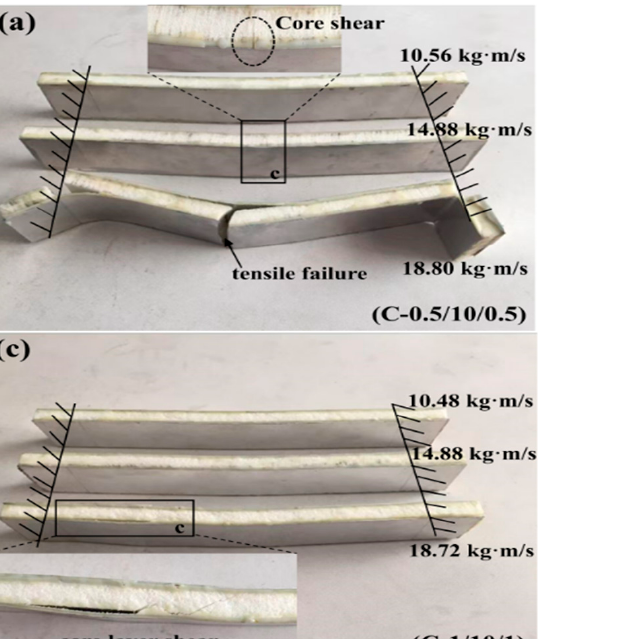
Figure 9. The impact force–time curve of the sandwich beams: ( a ) C-0.5/10/0.5; ( b ) C-0.5/20/0.5; ( c )